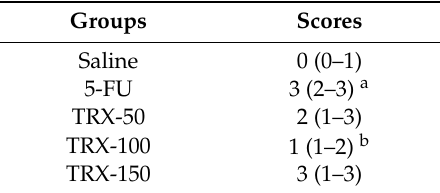
Table 2. Histopathological scores of mice subjected to 5-FU-induced intestinal mucositis and pretreated with